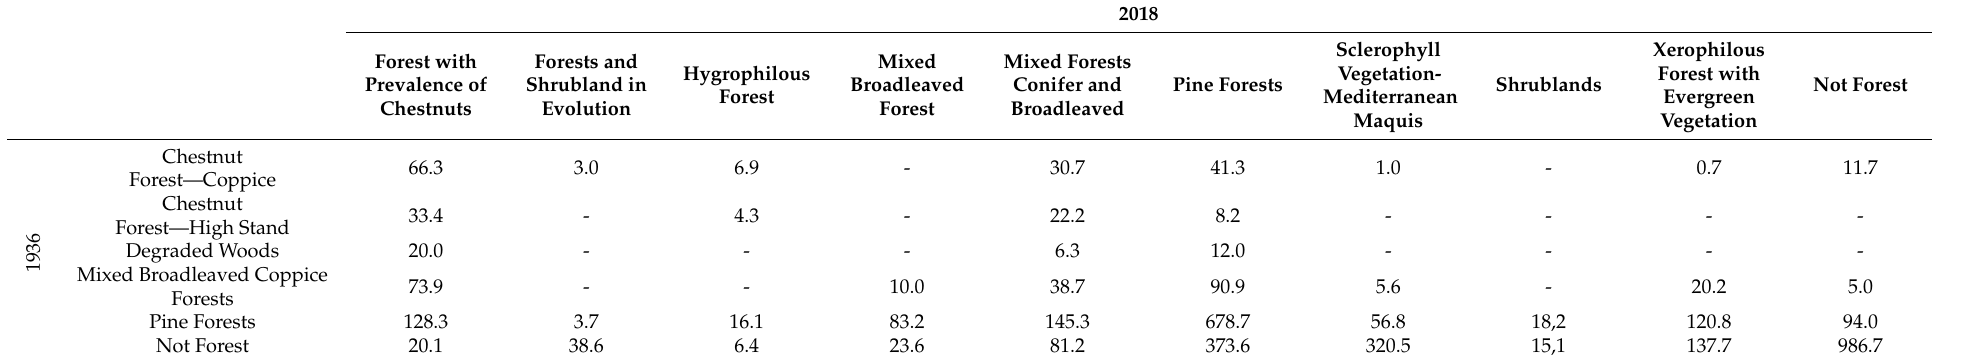
Table 4. Cross tab of the forest changes for the different typologies in the period